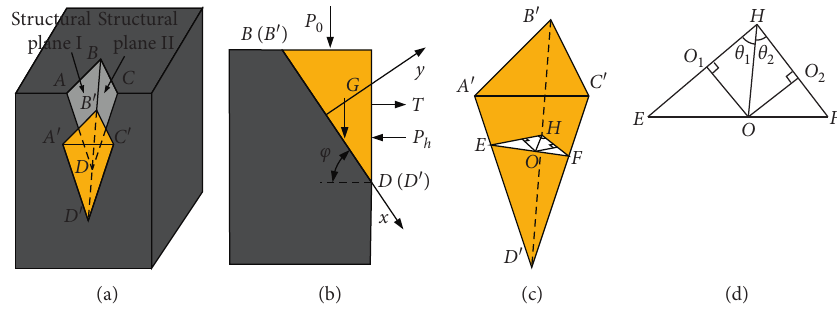
Figure 5: Analytical model of wedge stability at the coal